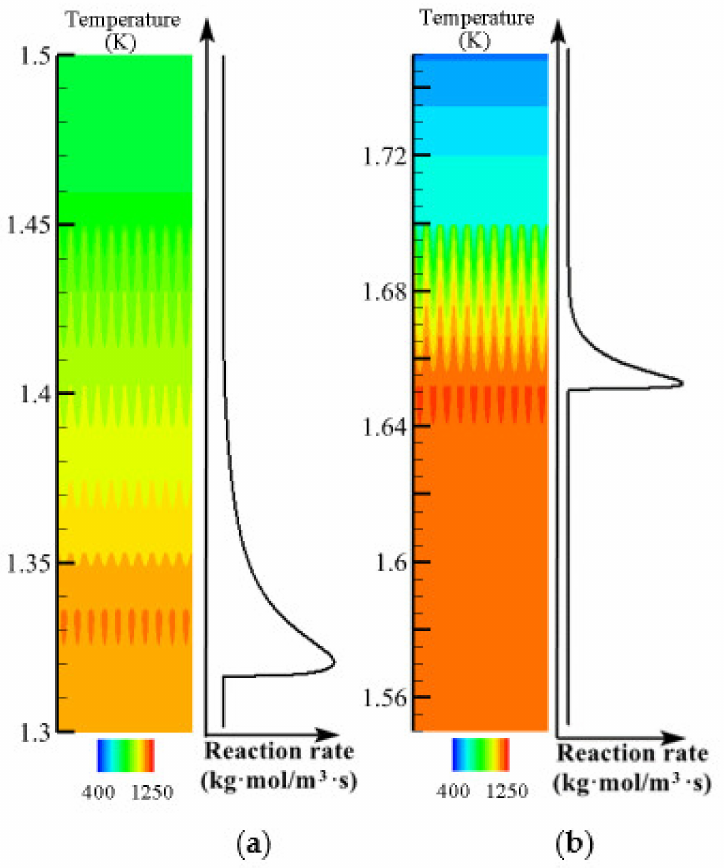
Figure 26. Comparison of temperature field in the reaction zone with an inlet flow rate of 700 m 3 /h, X CH = 0.6%, t = 400 s. ( a ) The initial temperature is set to T 1 ( y ). ( b ) The initial temperature is set 4 to T 7 ( y ).